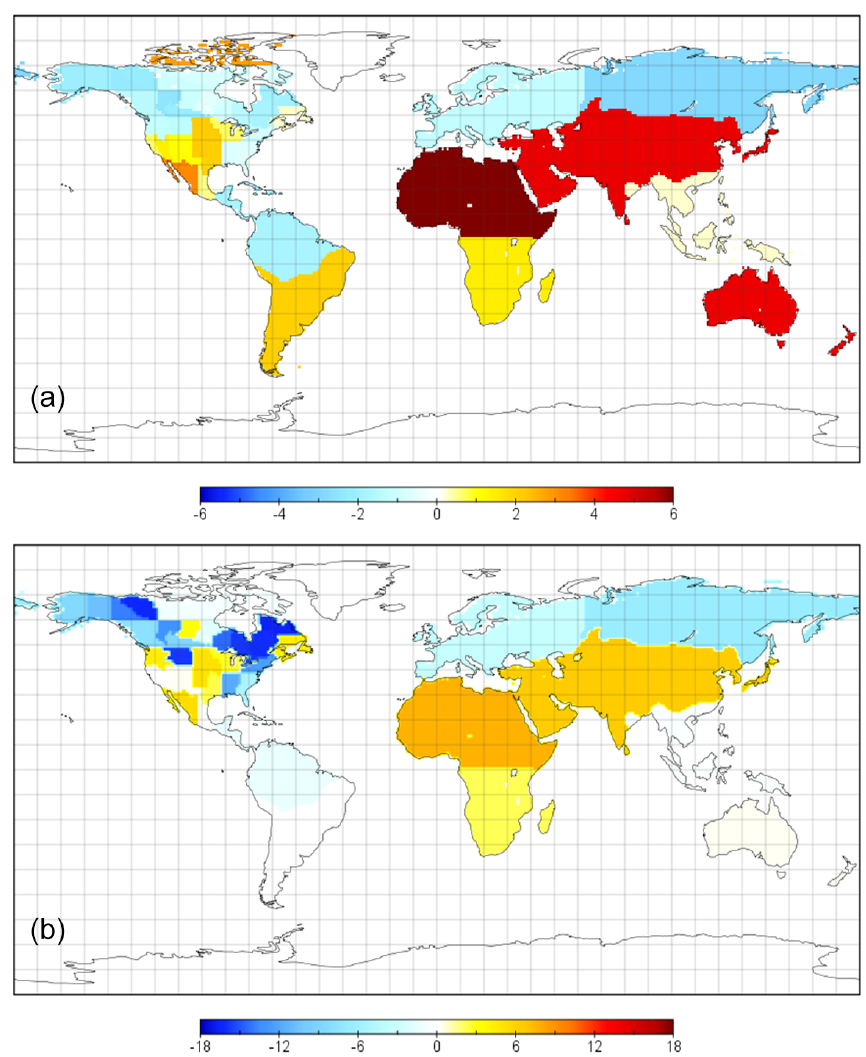
Figure 12. (a) Difference in ε lph (‰) and (b) the inverted CO 2 flux (g Cm − 2 year − 1 ) between case I and case II, i.e. Case I minus case II. See Sect. 2.1.3 for the description of these